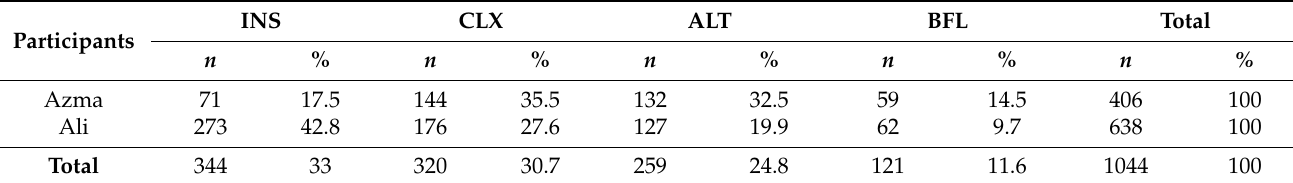
Table 3. Frequency of the four types of code-switching in our data set.